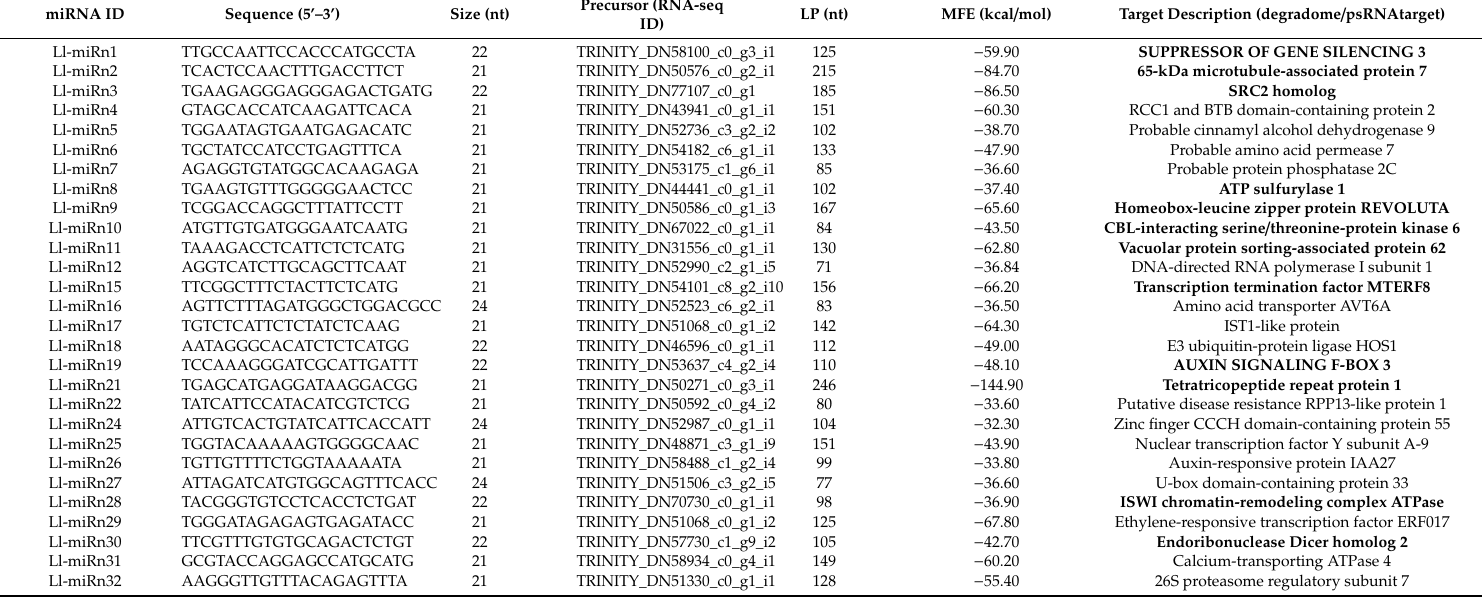
Table 3. Novel miRNAs identified in Lupinus luteus